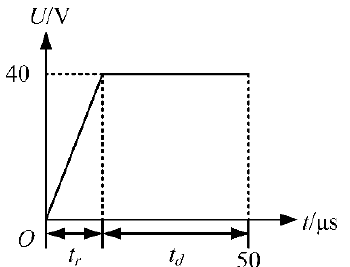
Figure 3. Waveform used in the optimization of t r .